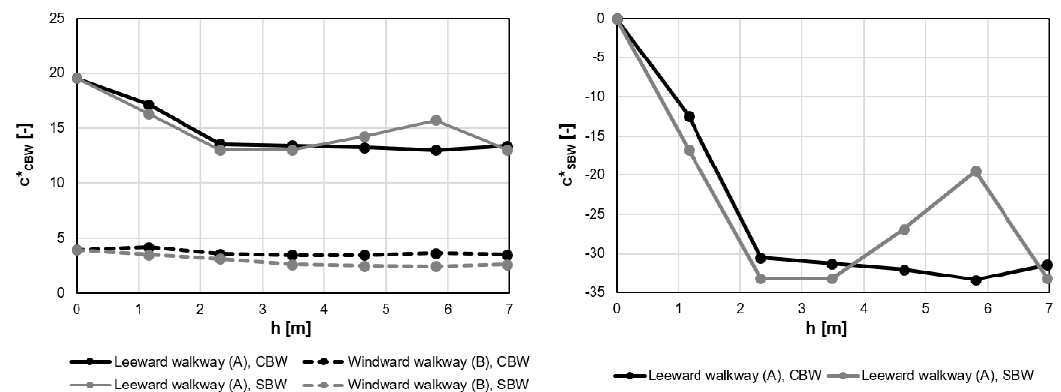
Figure 14. ( Left ) area-weighted averages of normalized concentration on the leeward and windward walkways (6 m wide surfaces along the entire building length), as functions of LBW height. ( Right ) normalized concentration changes at the leeward walkway as functions of LBW heights.